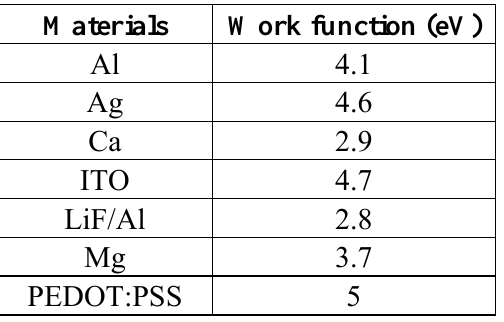
Table 6. Work function of some of the commonly used materials as anode or cathode in QLED, solar cell and